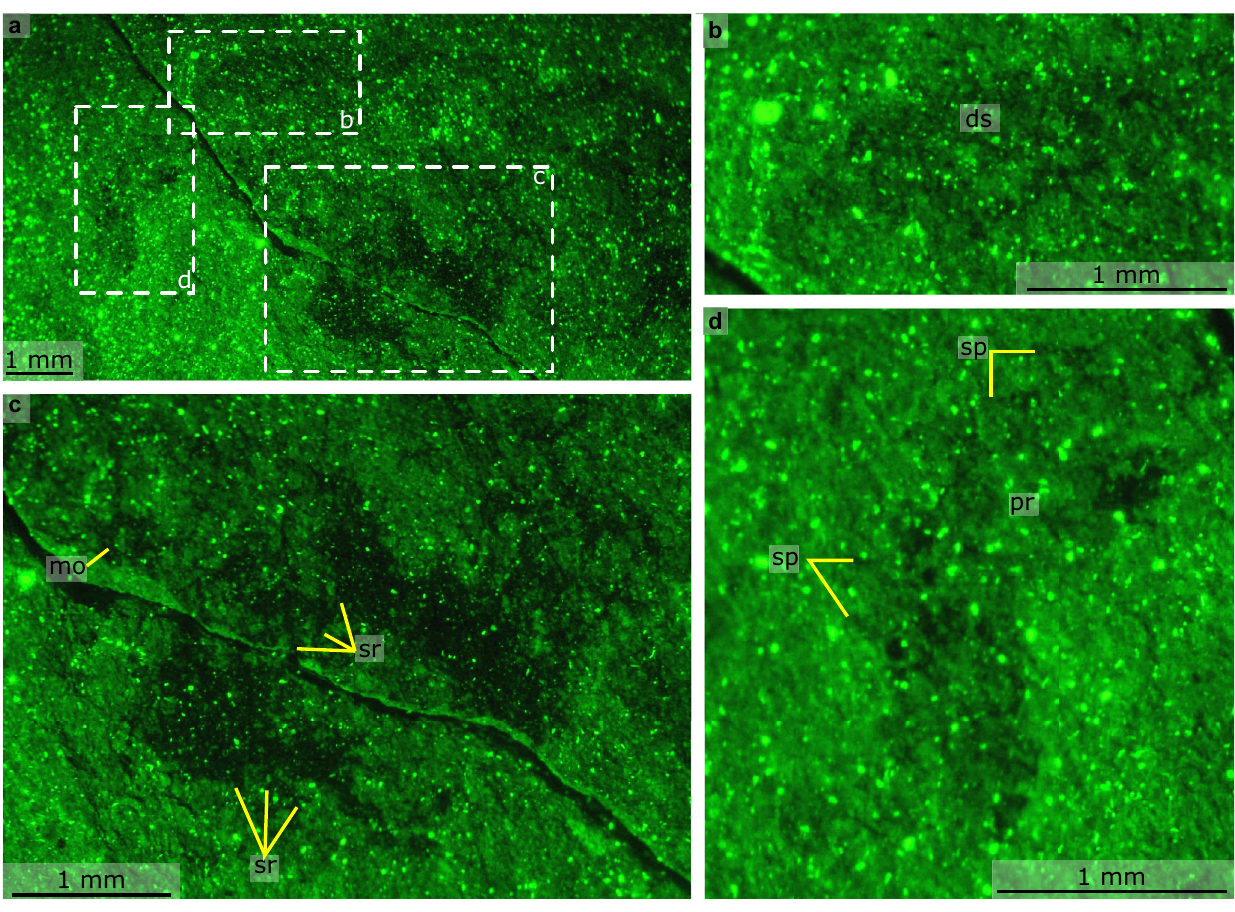
fl aps with strengthening rays. d Proboscis with spines. ds dorsal sclerite, pr pro- boscis, sp spine, sr strengthening